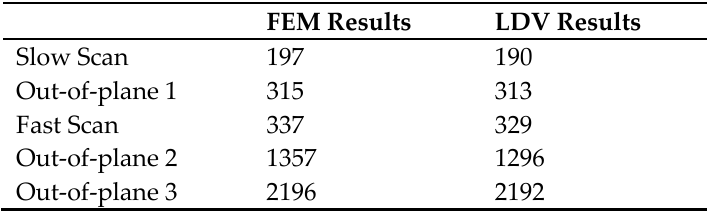
Figure 2. ( a ) Fabricated stainless-steel scanner. ( b ) Frequency response of the device. Exact frequency values of the corresponding modes are provided in Table 2. Table 2. Comparison of mode frequencies (all in